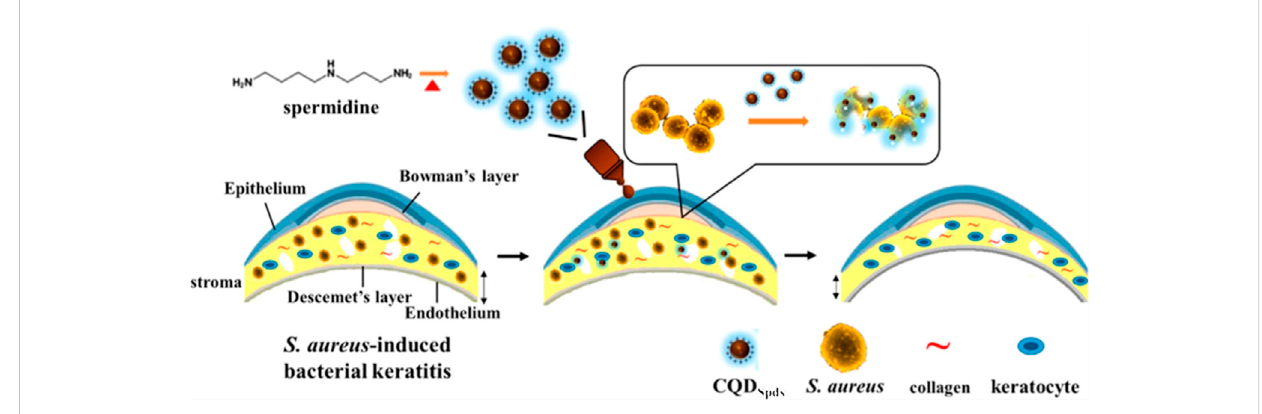
FIGURE 7 Intracellular mGQDs in DAPI-stained L929 cells. (A) Optical slice with x -, y -axes and projections of x -, z -and y -, z -axes of L929 cells; (B) 2.5D imaging and (C,D) 3Dintracellular imaging exhibiting localization signals from DAPI-stained nuclei and mGQD-stained cytoplasm (Kumawat etal., 2017).